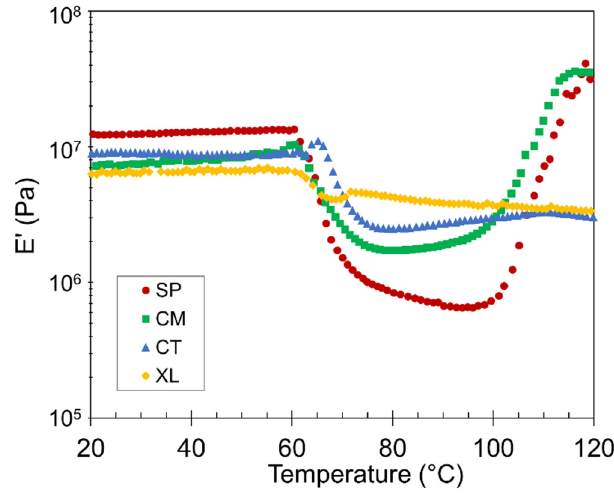
Figure 6. Representative plots of E’ versus temperature for SP, CM, CT, and XL foams with 6.5 wt% CFA.